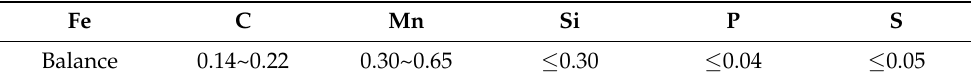
Table 2. Chemical composition of Q235 steel sheet expressed as weight percentages.